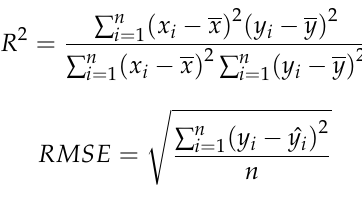
Figure 9. The schematic diagram of RF. Additionally, the determination coefficient ( R 2 ), root mean square error ( RMSE ) and mean absolute error ( MAE ) were selected as the evaluation indices, and the prediction results of the model were evaluated, as shown in Equations (4)–(6). Finally, the results were evaluated in parallel by Lin’s Concordance Correlation Coefficient (LCCC).